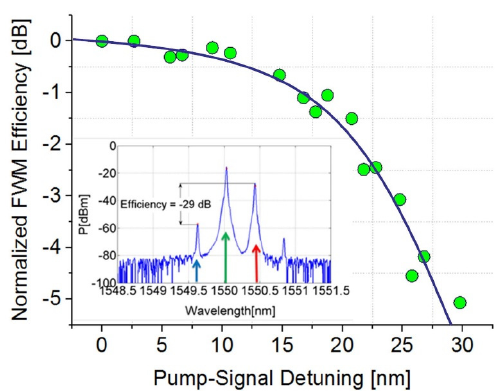
Figure 2. Normalized FWM (Four Wave Mixing) efficiency as a function of pump ‐ signal detuning. The waveguide length was 2.26 cm. Inset: Spectrum recorded after propagation along the waveguide [26,28].